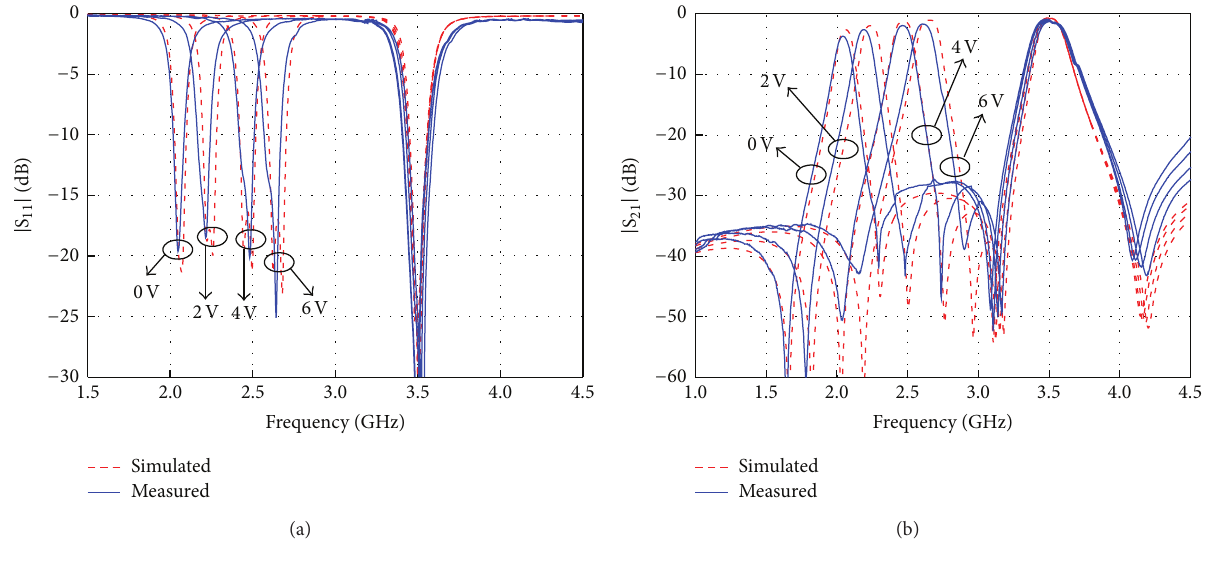
Figure 8: Simulated and measured results (a) S 11 and (b) S 21